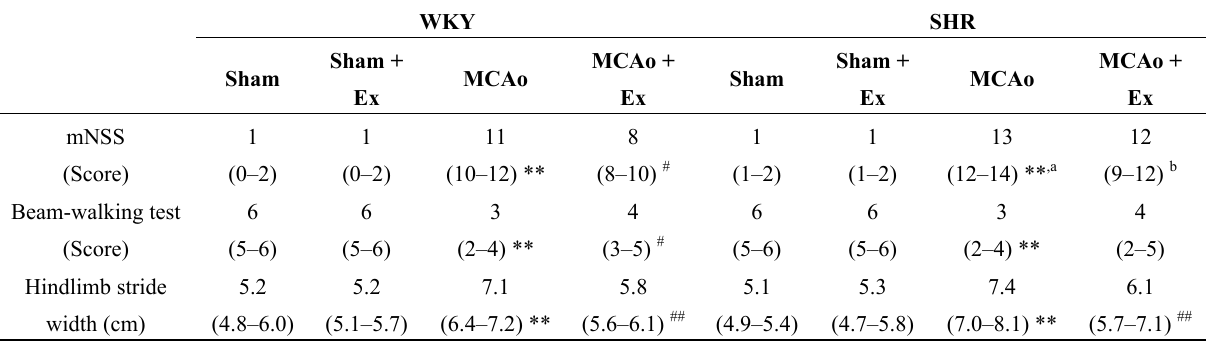
Table 1. Mann-Whitney analysis of mNSS score and motor dysfunction in WKY and SHR rats with sham or MCAo surgery. mNSS score, balance beam scores and hindlimb stride width were assessed in WKY and SHR rats after forced treadmill exercise for 4 weeks.